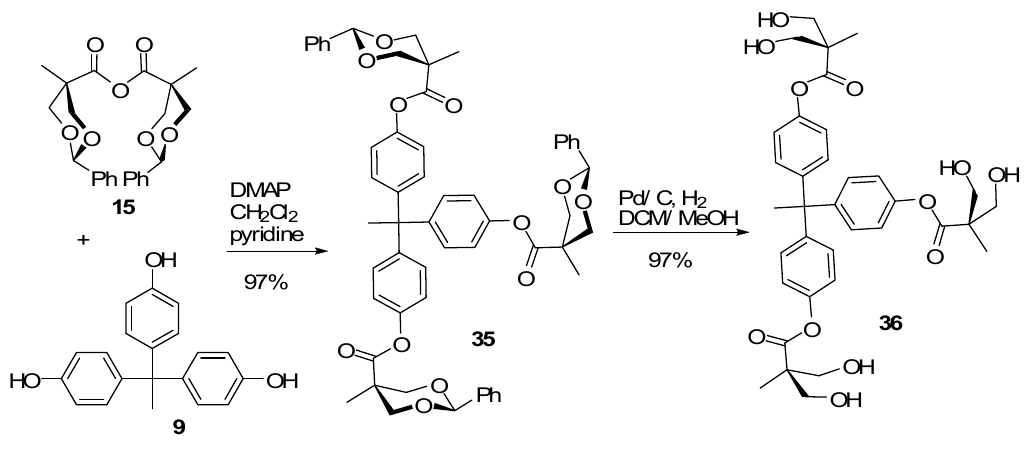
Figure 3. Hydroxyl-terminated fourth generation polyester dendrimer